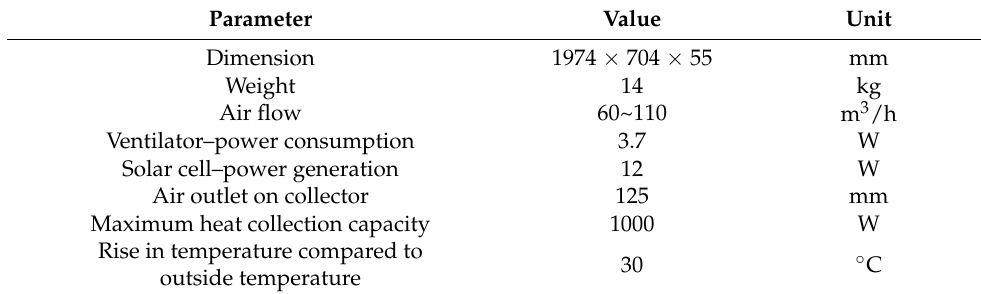
Table 1. Technical data specification of the wall-mounted a solar air heater.